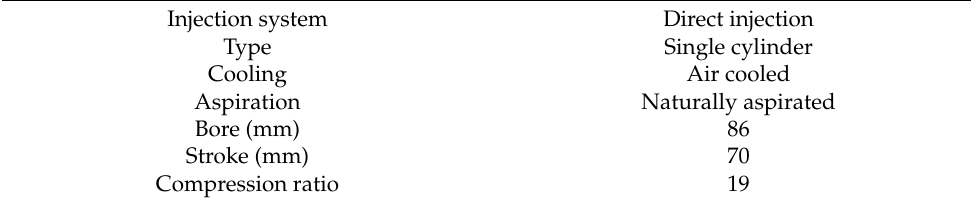
Figure 1. Scheme of the experimental set-up where 1 is the sampling compressor, 2 is the dilution compressor, and T is the temperature sensor. PM is the particulate matter sensor and NOx is the sensor measuring NO and NO 2 . Table 1. Engine (JavacNanomag NM 7500 B (KM 186FA)) specifications.